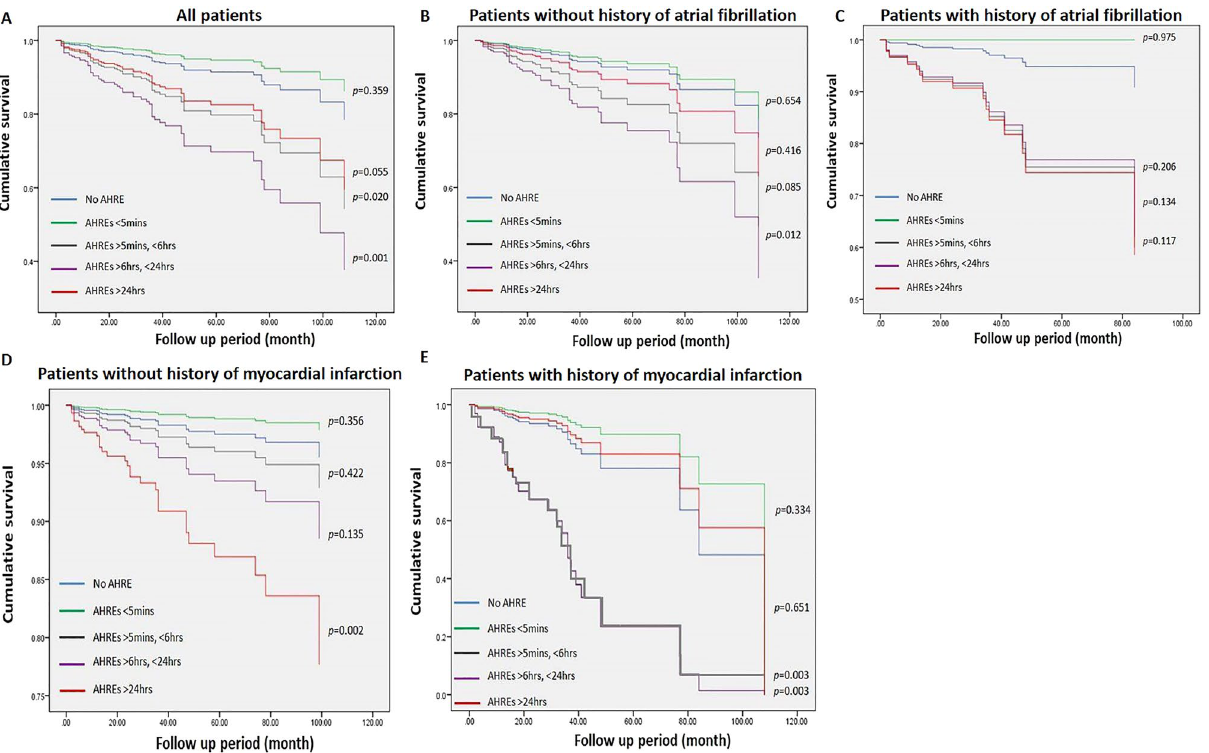
Figure 2. Cox regression event-free survival curves from primary endpoint at 39.9 ± 29.8 months of follow-up based on five subgroups. (A) All patients. (B) Patients without history of AF. (C) Patients with history of AF. (D) Patients without history of MI. E: Patients with history of MI. ( AF atrial fibrillation, MI myocardial